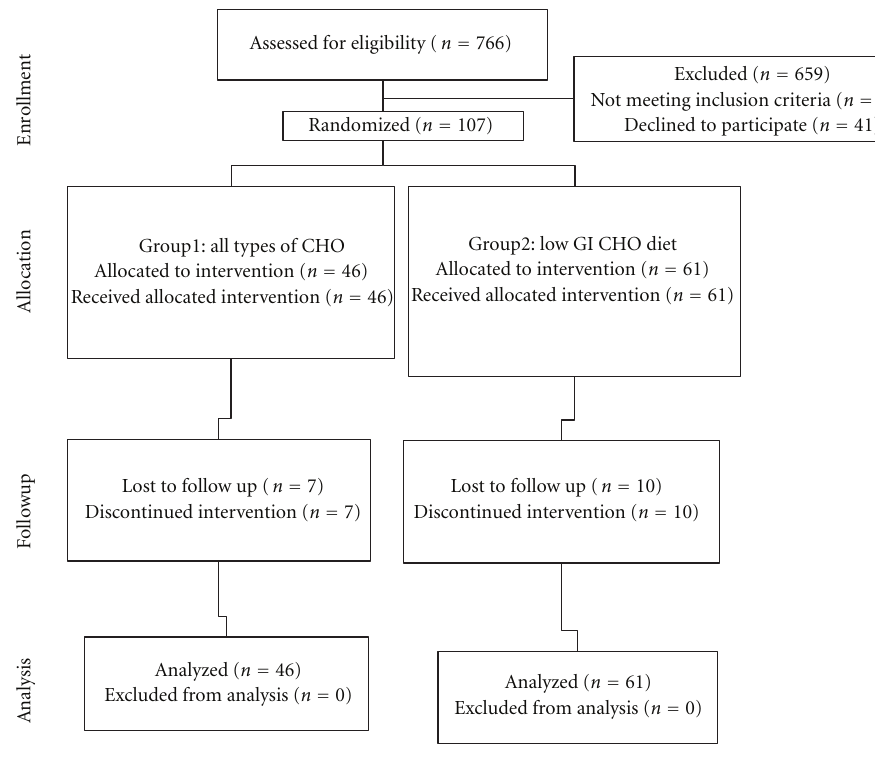
Figure 1: Flow diagram of